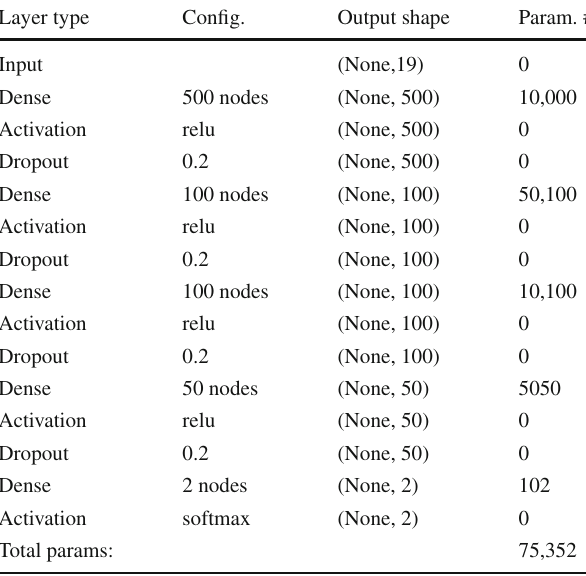
The network was trained on the z-score normalised ATLAS dataset [1] of 310,324 data points, of which 10% was used for